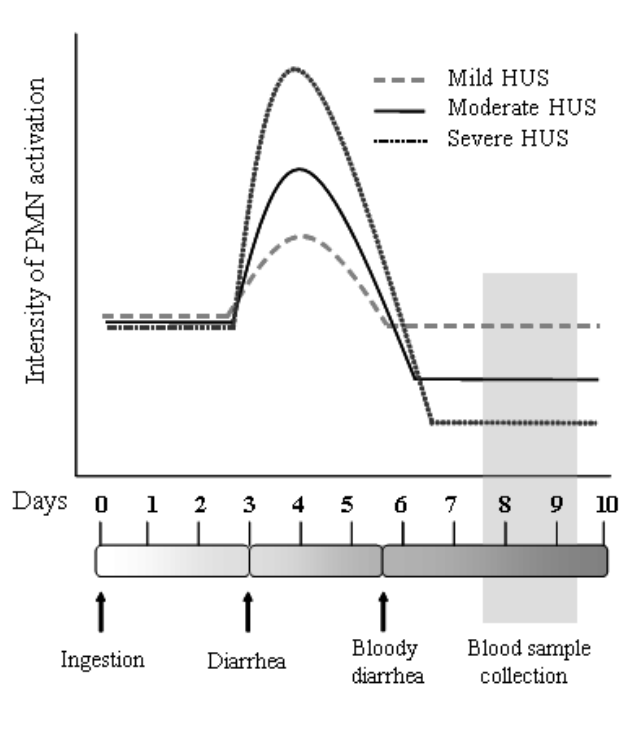
FIGURE 2. Intensity of PMN activation during the course of Shiga toxin-producing E. coli infection. Approximately, liquid diarrhea starts 3 days after ingestion of the Shiga toxin-producing bacteria, indicating the colonization of bacteria. Stx is synthesized and secreted by the bacteria attached to the intestinal mucosa, and the damage produced leads to bloody diarrhea. Usually children are hospitalized 3 or 4 days after the beginning of bloody diarrhea. PMN activation probably occurs before hospitalization, and at the moment of sample collection PMN are found deactivated in degrees that depend on the intensity of their previous activation. PMN form patients with mild renal damage (mild HUS) will show the lowest activation, patients with moderate renal dysfunction (moderate HUS) an intermediate activation and severe cases of HUS (severe HUS) the highest degree of PMN activation. This will derive in minor, intermediate and marked alterations in PMN phenotype and functionality for mild, moderate and severe cases of HUS, respectively, at the moment of sample